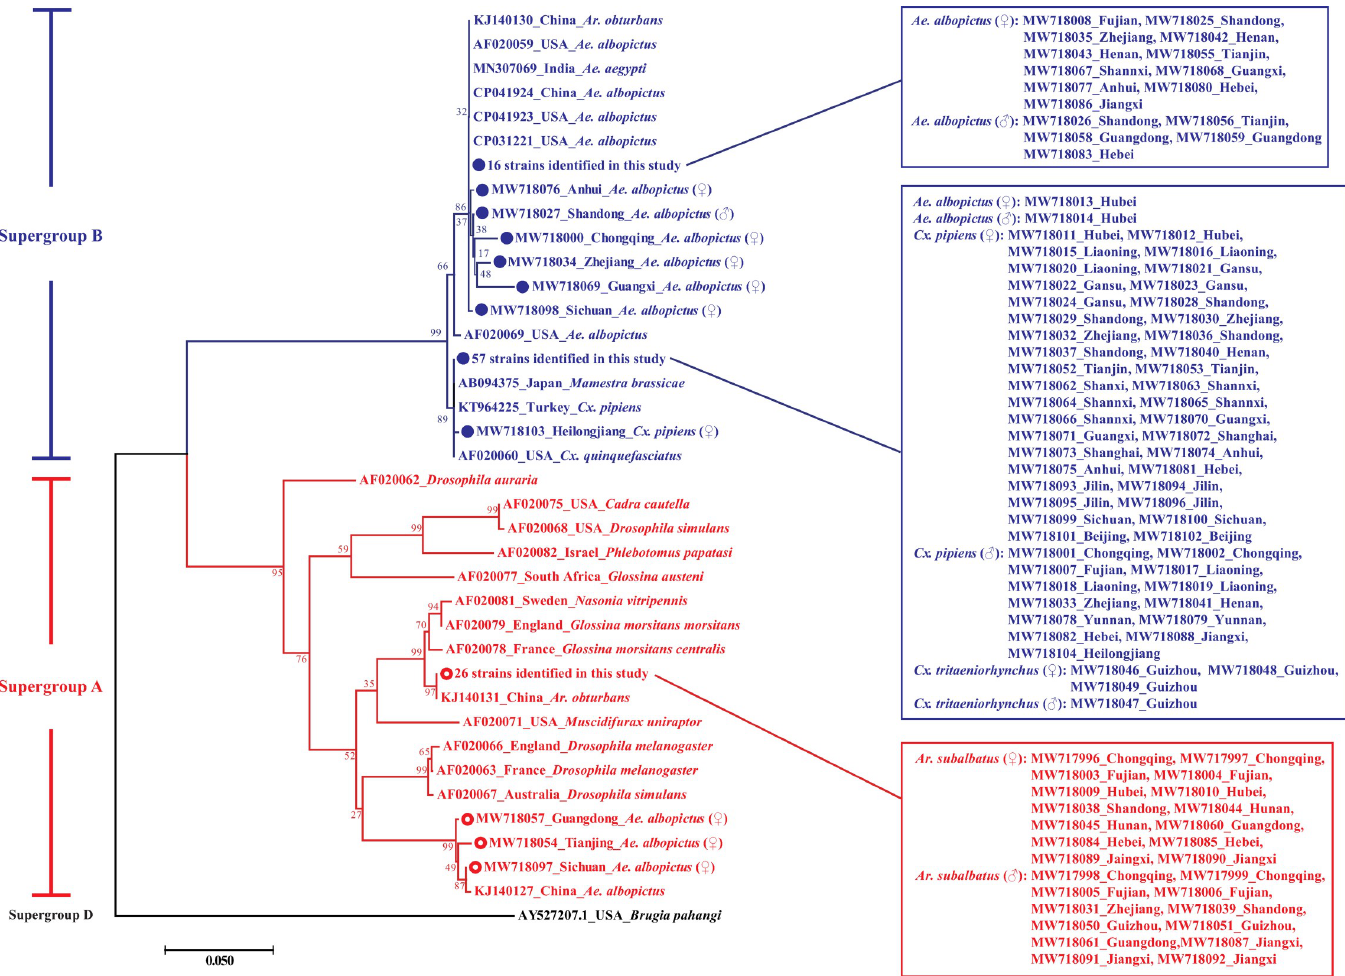
Fig 2. Neighbor-joining phylogenetic tree based on Wolbachia wsp gene partial sequences (~610 bp) obtained in this study and GenBank database. Strains identified in this study are identified with open circles ( � ) for supergroup A (in red) and filled circles (•) for supergroup B (in blue). The numbers at the branches show bootstrap support (1000 replicates). The bar at the bottom of the figure denotes